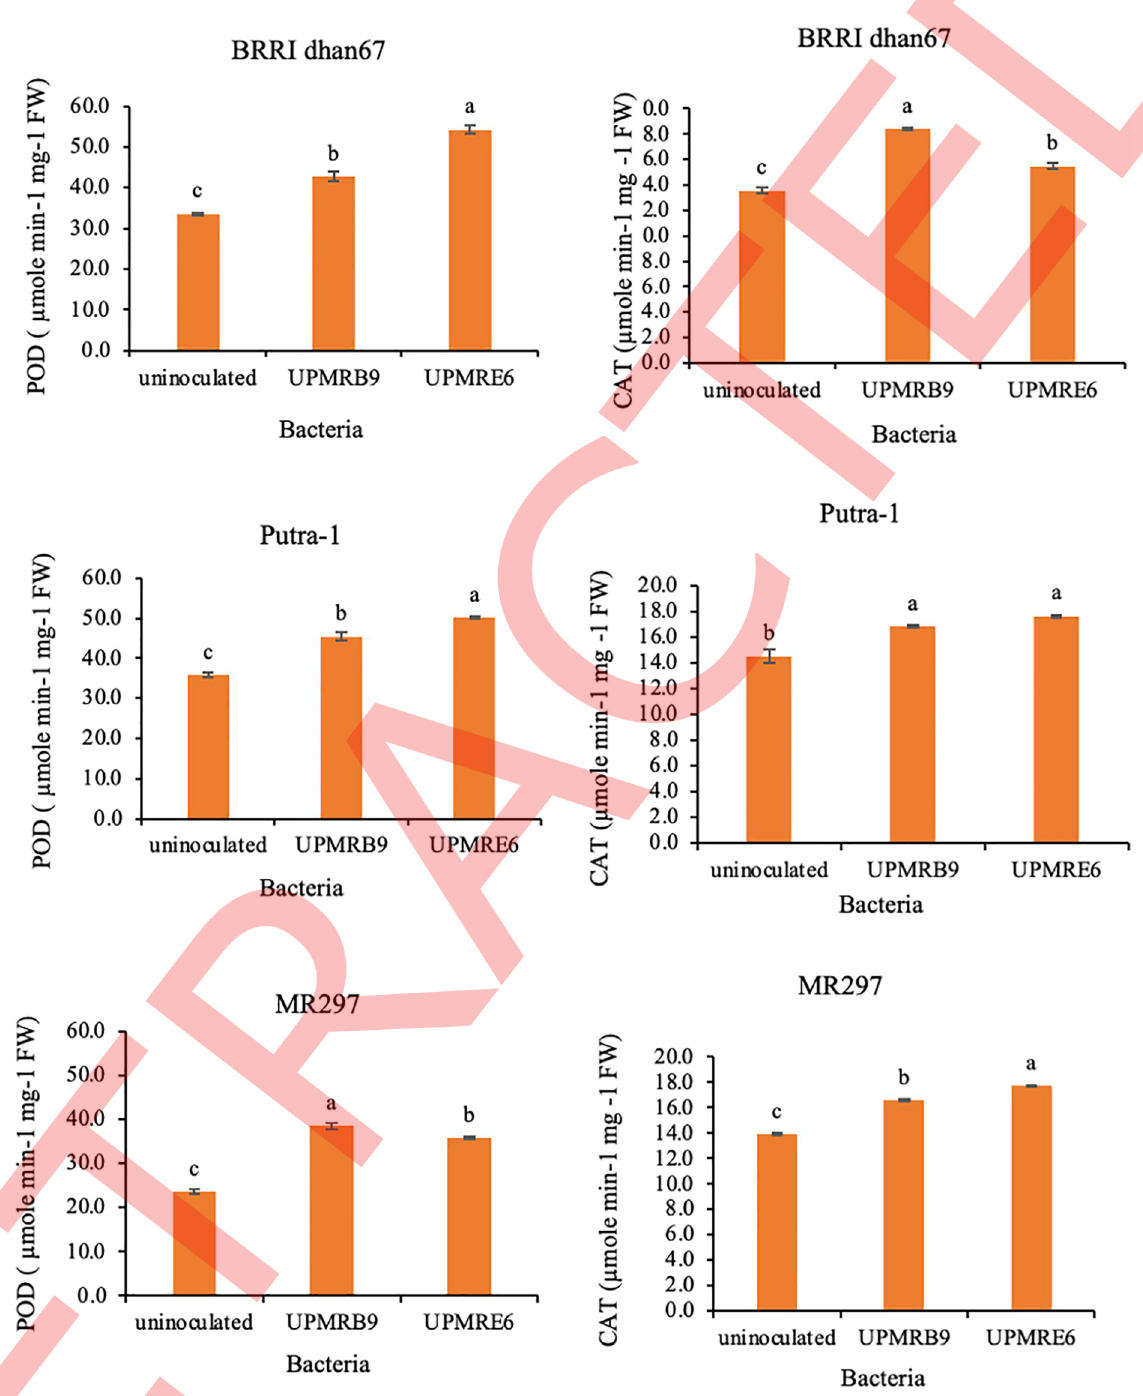
Fig 5. Effect of bacterial inoculation peroxidase (POD) and catalase (CAT) activity in rice varieties under salt. Means having the same letter within each variety do not differ significantly at the probability level 0.05 by Tukey (HSD).